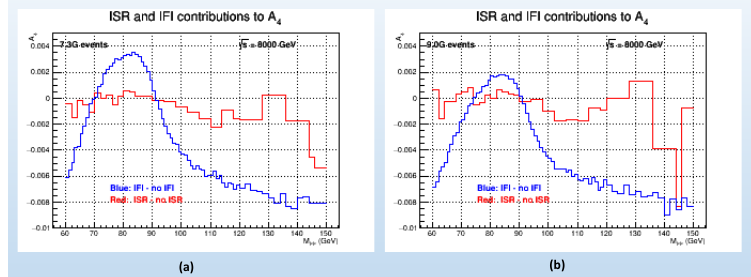
Figure 3: Mass comparison for A results calculated with m masses increased by a factor of